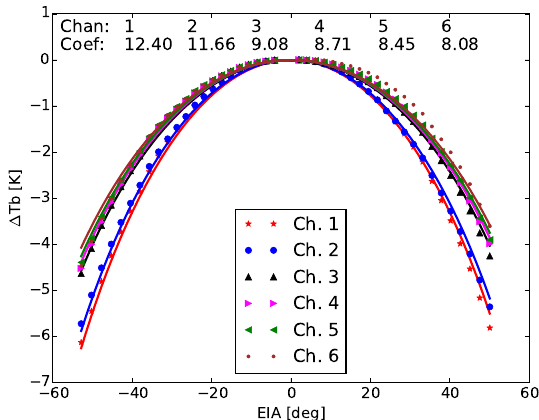
Figure 2. Limb-darkening effect as a function of earth incidence angle (EIA) for different SAPHIR channels. The empirical coeffi- cients for Eq. (2) are also printed on the